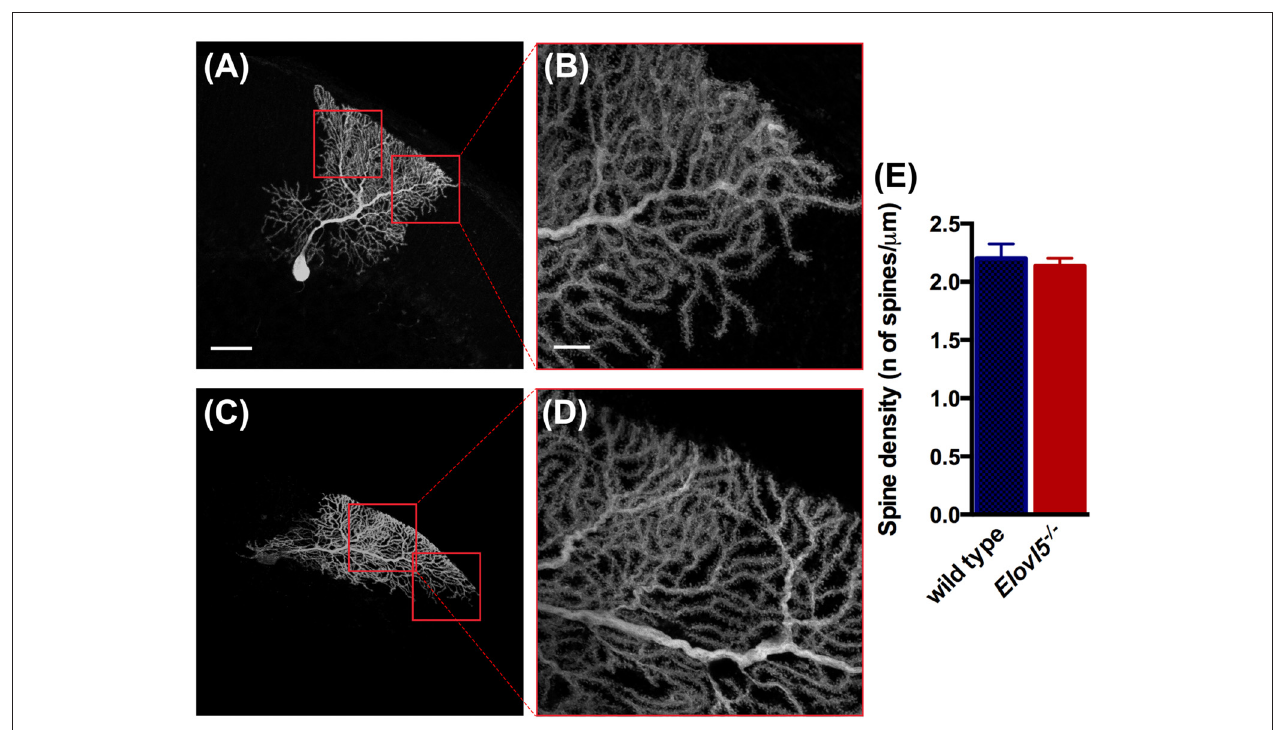
FIGURE 7 | Normal number of spines in PC dendrites of Elovl5 − / − mice. (A,C) Representative PCs filled with biocytin from wild type and Elovl5 − / − mice, respectively. (B,D) Higher magnification images of the dendritic arbor from the cells represented in (A,C) . Scale bars: for (A,C) 40 µ m; for (B,D) 10 µ m. (E) Spine density obtained from the analysis of more than 15 dendrites per PC (number of cells: n = 7 wild type and n = 8 Elovl5 − / − PCs). Three animals per genotype were